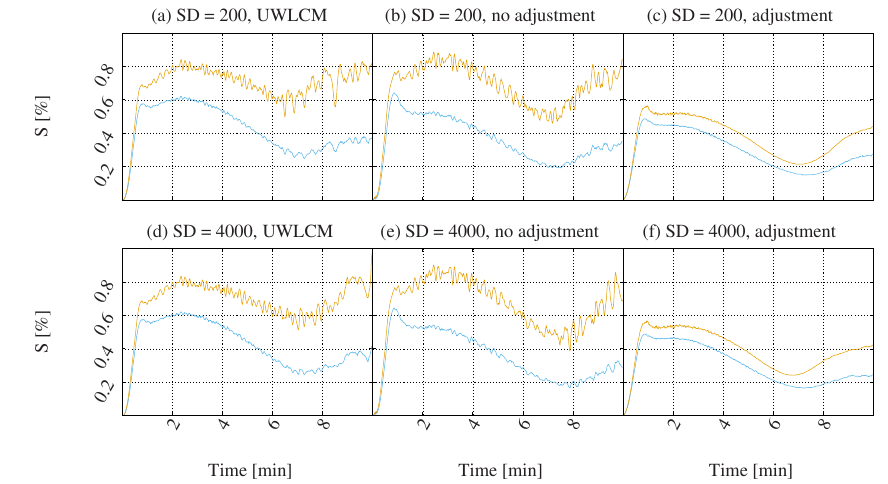
Figure 7. Comparison of the mean supersaturation averaged over the cloudy points for UWLCM (a, d) and the Twomey super-droplet scheme without (b, e) and with (c, f) the adjustment to avoid unphysical cloud-edge supersaturation fluctuations. The blue and brown lines represent the mean and the mean plus the standard deviation of the spatial distribution. Panels (a–c) and (d–f) are for simulations with 200 and 4000 super-droplets (UWLCM) or number of divisions (Twomey scheme). Data are plotted at every time step of the fluid flow